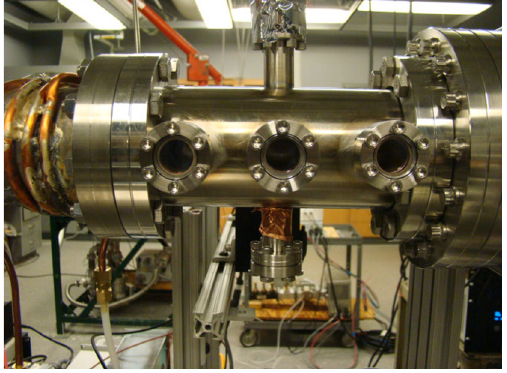
FIG. 2. Cylindrical processing cavity.